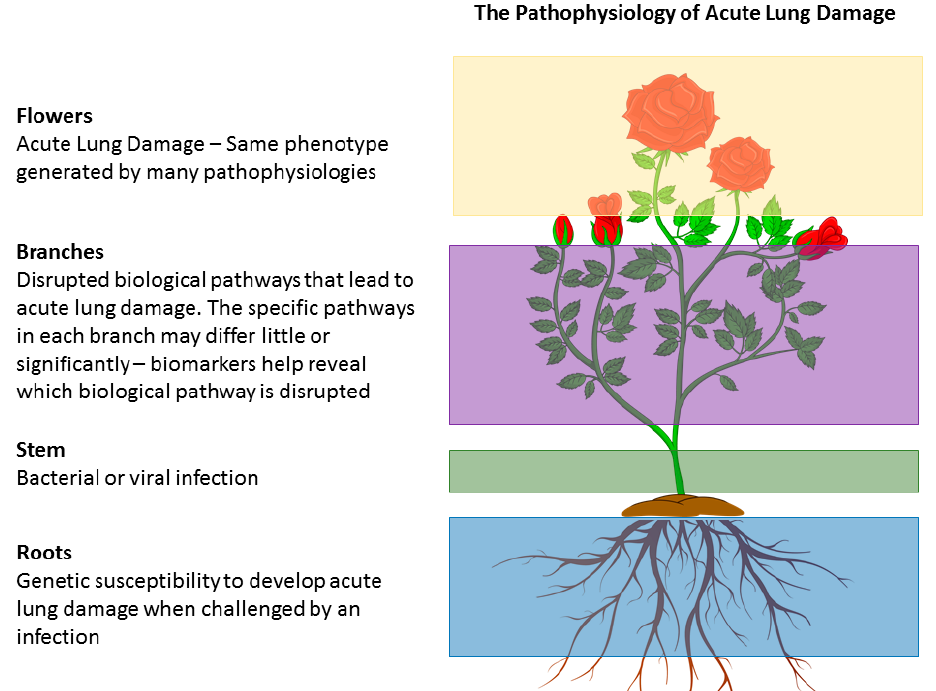
Figure 3. Conceptualization of ‘Omics’ approach in acute lung injury .